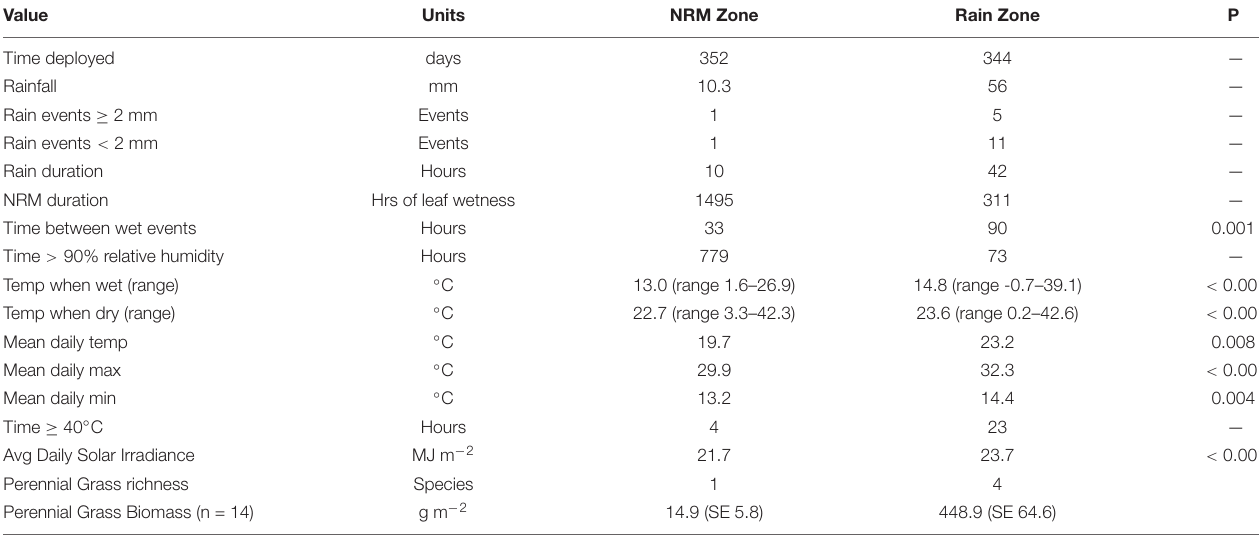
TABLE 1 | Site differences during the one-year study period. Value Units NRM Zone Rain